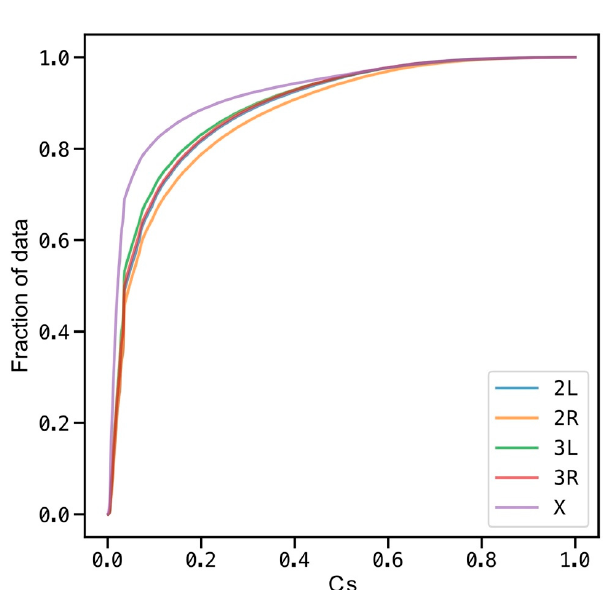
Figure A1. Conservation at CDF was calculated for Cs values (Cs > 0) for each chromosome arm. On average, 90% of the genomic positions that show some conservation have Cs less than 0.32. Cs = 1 occurs on 150 positions across the analyzed genome (chromosome arms 2L, 2R, 3L, 3R and X).